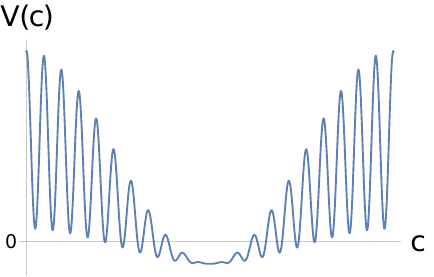
Figure 11 . The axion potential of (cid:12)gure 10 with an additive correction (cid:14)V ( c ) / const.+cos( c=f e(cid:11) ) that shares the periodicity of the